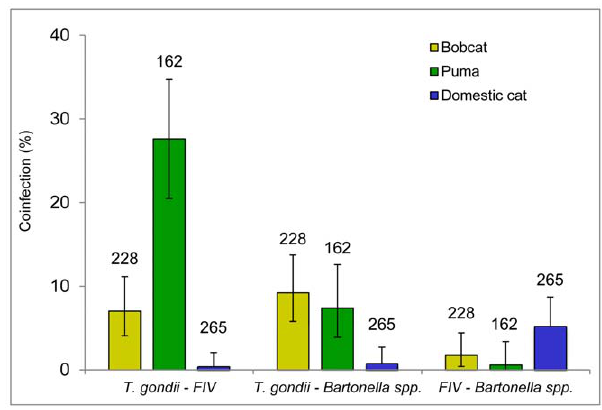
Figure 3. Coinfection rates, with bars representing 95% confidence intervals, of FIV/ T.gondii IgG coinfection, T.gondii IgG /Bartonella spp. coinfection, and FIV/ Bartonella spp. coinfec- tion, for bobcats (n=228), pumas (n=162), and domestic cats (n=265).